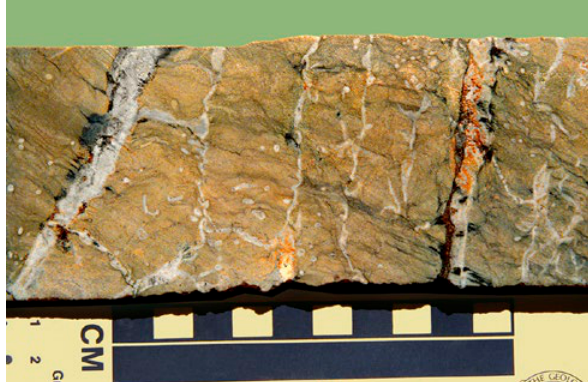
Figure 28. Several types of early diagenetic crosscutting sediment veins ranging from irregular quartz veinlets ‘splashed’ within the ooze, ‘dirty early quartz’ veinlets, and later quartz-chlorite veins re- injected beside original veins, illustrate stages in “the birth of quartz veins” in this soft diagenetic siliceous ooze intersected in the Wagga Tank prospect drilling in Mt Hope district,